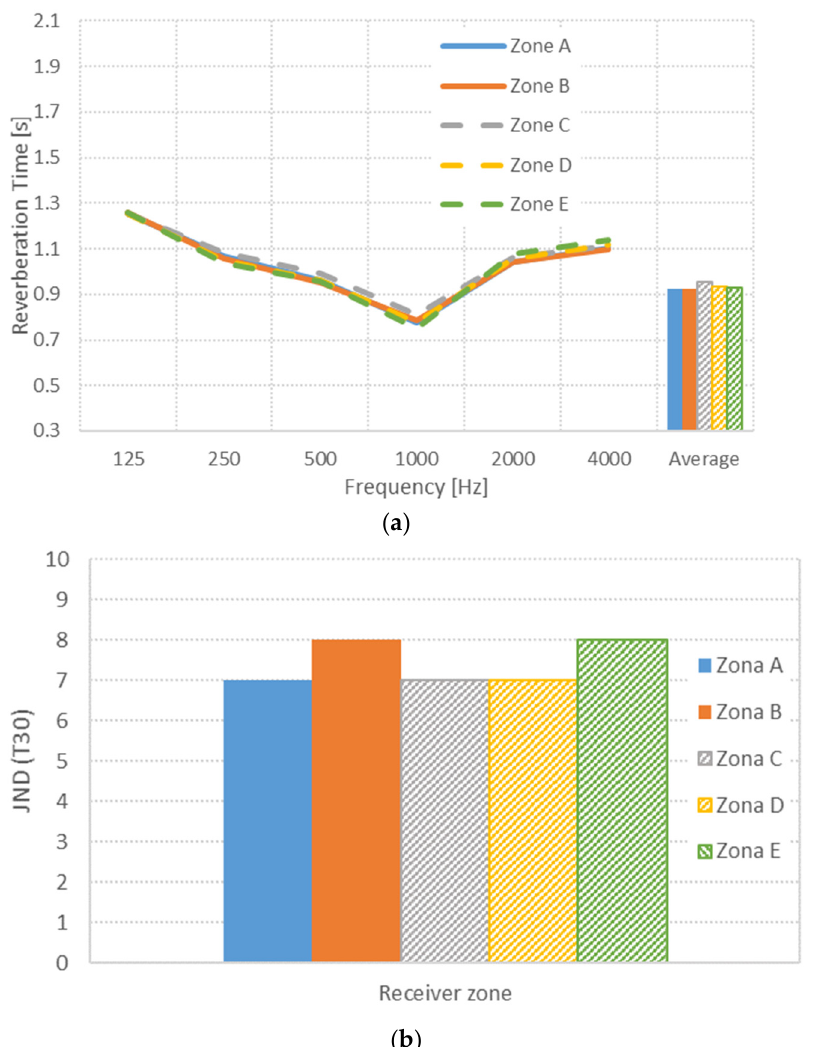
Figure 9. Reverberation time ( a ) and JND ( b ) obtained for the auditorium, when the variable acoustic solution provides maximum absorption, by zones (configuration A).